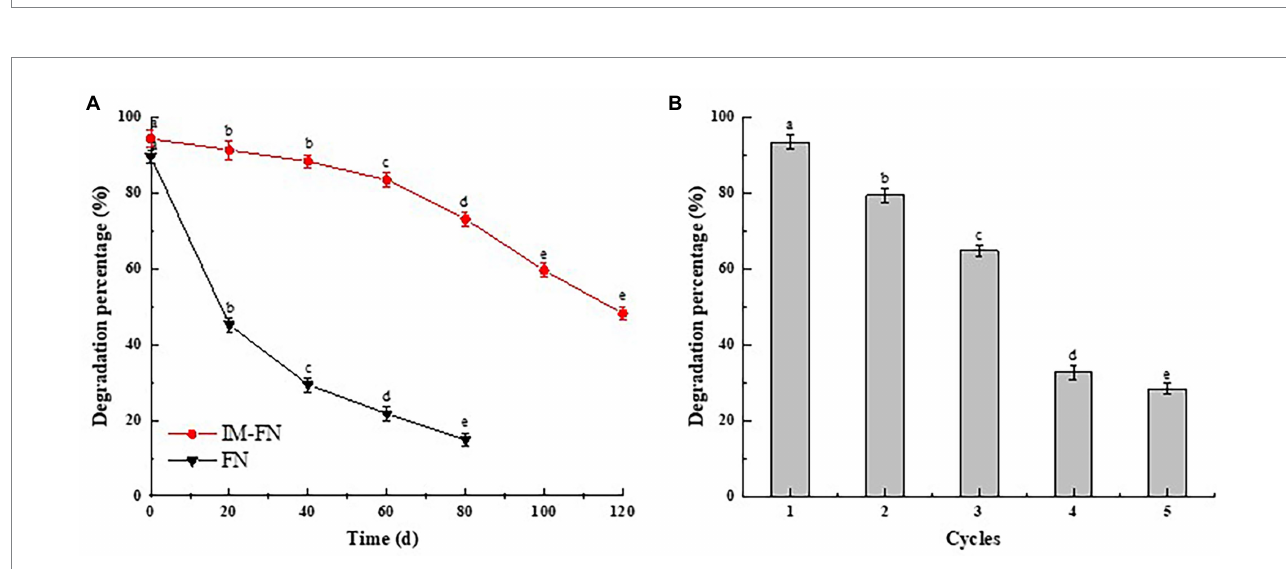
FIGURE 6 The storage stability (A) and reusability (B) of immobilized bacterial mixture (IM-FN). Different letters (a, b, c, and d) indicate significant difference between the same treatment at different times based on Duncan’s significant difference test ( p ≤